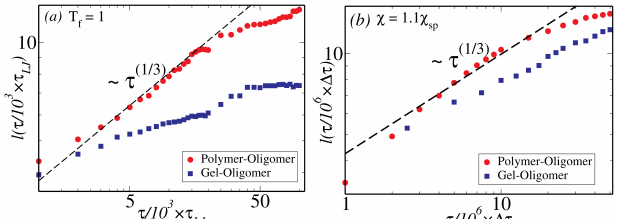
Figure 2. The time-dependence of the coarsening length as a function of time computed from bulk simulations for polymer–oligomer mixture (shown in red filled circles) and gel–oligomer mixtures (shown in blue-filled squares) simulated via MD simulations ( a )) and via meso-scale simulations, where the gel has a bulk modulus, B = 0.05 ( b